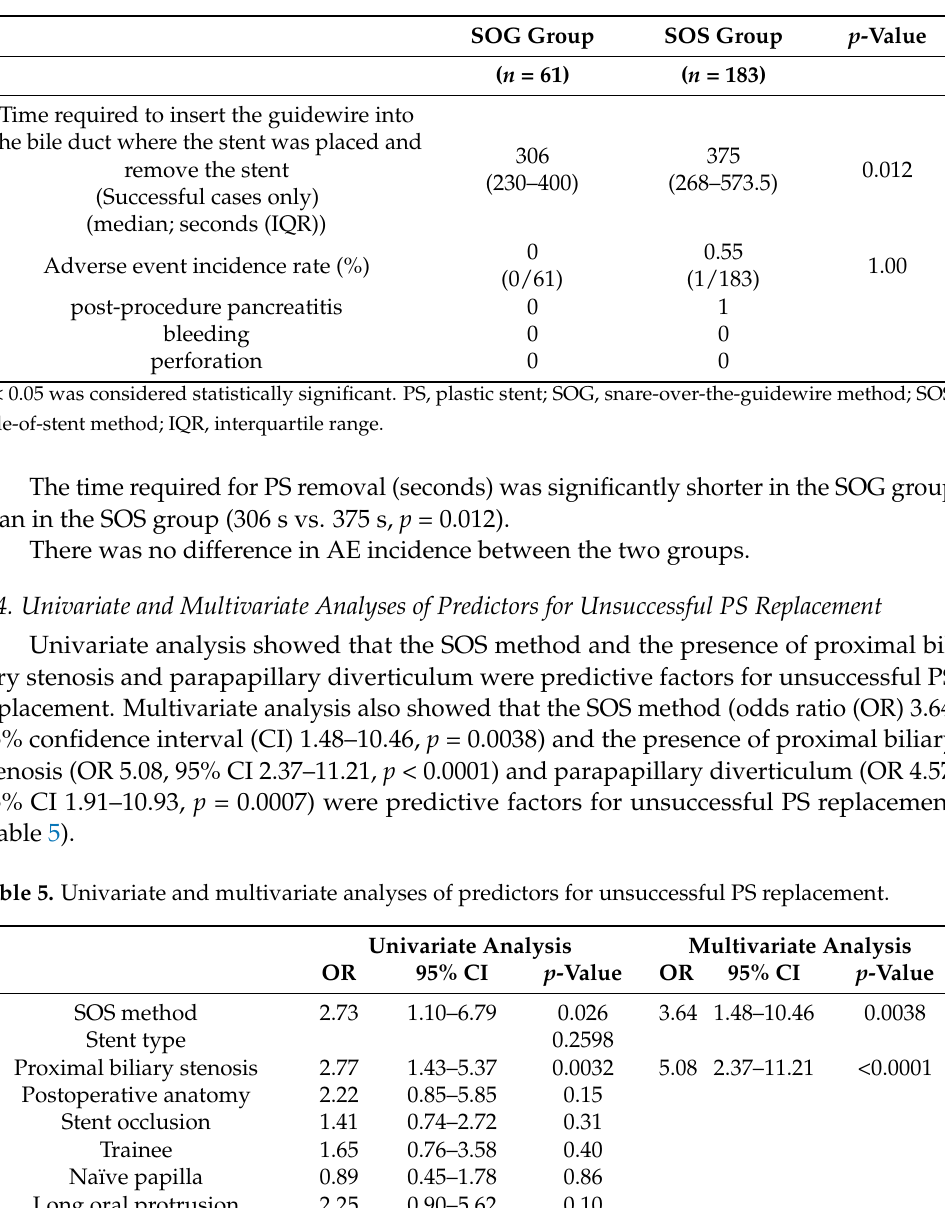
Table 4. Comparison of the time required for PS removal and adverse event incidence rate between the SOG and SOS groups.